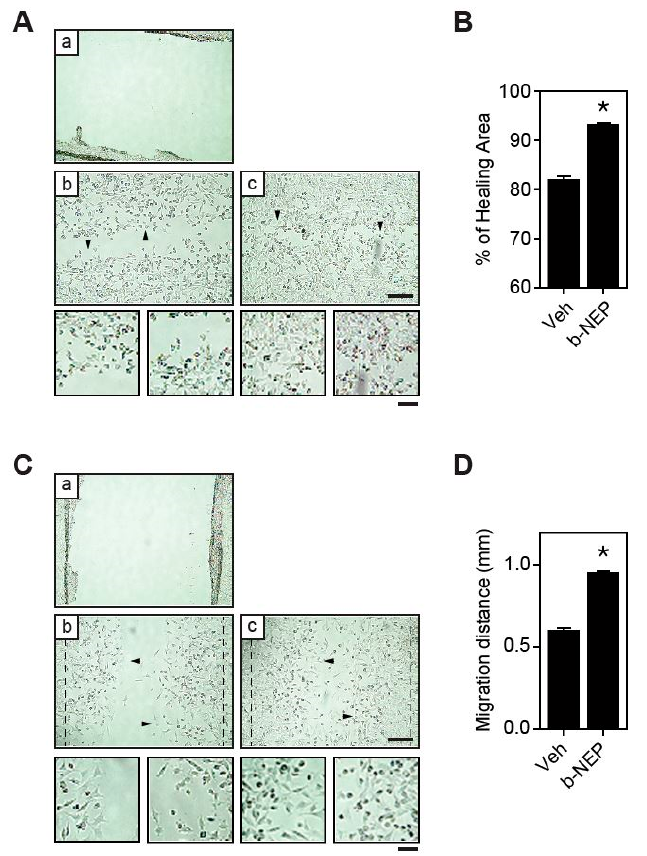
Figure 4. β -NEP stimulates migration in the fibroblast. ( A ) Mouse embryonic fibroblast (MEF) cells were grown to confluence and scratch wound was created using pipet tips (a). Cells were incubated for 12 h in the absence (b) or presence of β -NEP (c). Scale bar = 200 μ m. ( B ) Healing area (%) from ( A ). ( C ) MEF cells were scratched (a, T0) and treated with vehicle (b) or β -NEP (c) for 12 h in the presence of MMC (5 μ g/mL). Scale bar = 200 μ m. ( D ) Migration distance was calculated from ( C ). The arrowhead indicates that the region of magnification and magnified cell image are located at the bottom (scale bar = 20 μ m). The results represent the mean of three independent experiments. Data represent mean value ±SEM (* p < 0.05, Student’s t -test).